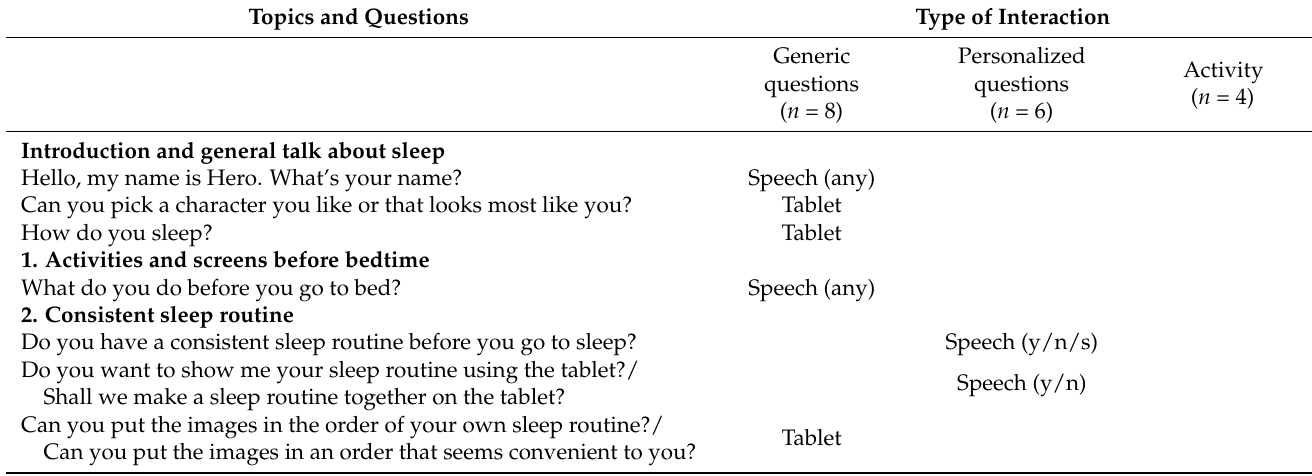
Figure 2. Examples of visual support by the tablet. © Illustrations by Patrizia D’Olivo. Table 1. Components of the interactive sleep